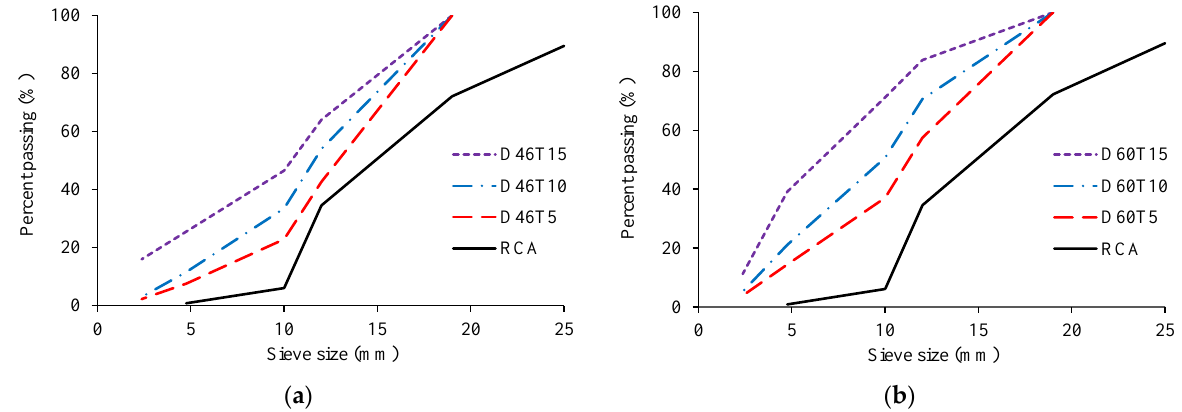
Figure 8. Influence of LA abrasion duration on RCA by balls of: ( a ) standard size (46-mm diameter); and ( b ) 60-mm diameter (Legends D p : p mm dia balls, T q : q minutes of LA abrasion duration).